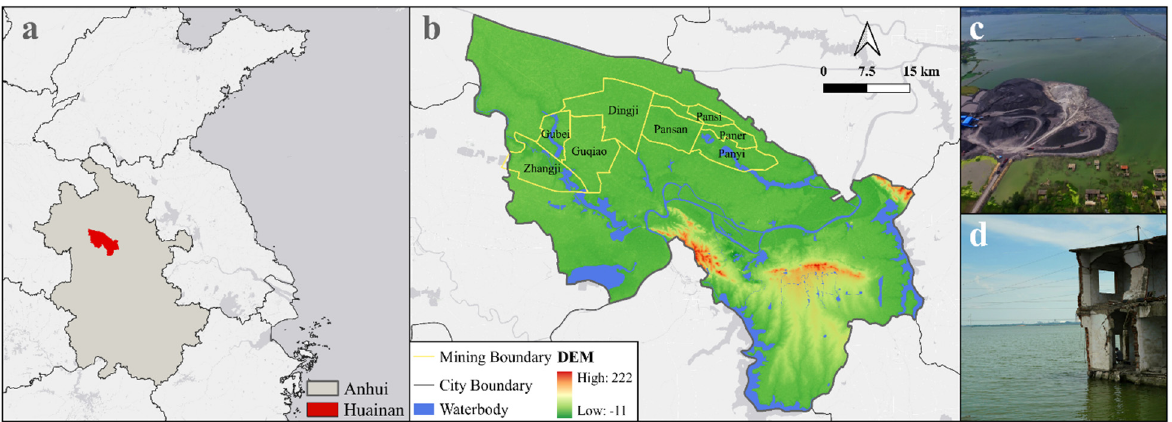
Figure 1 . Geographical distribution map of the study area. ( a ) location of Huainan City; ( b ) location of mining area for this study; ( c ) coal mining causes serious damage to surface ecology; ( d ) the villages in the coal mining subsidence area were flooded by ponding.